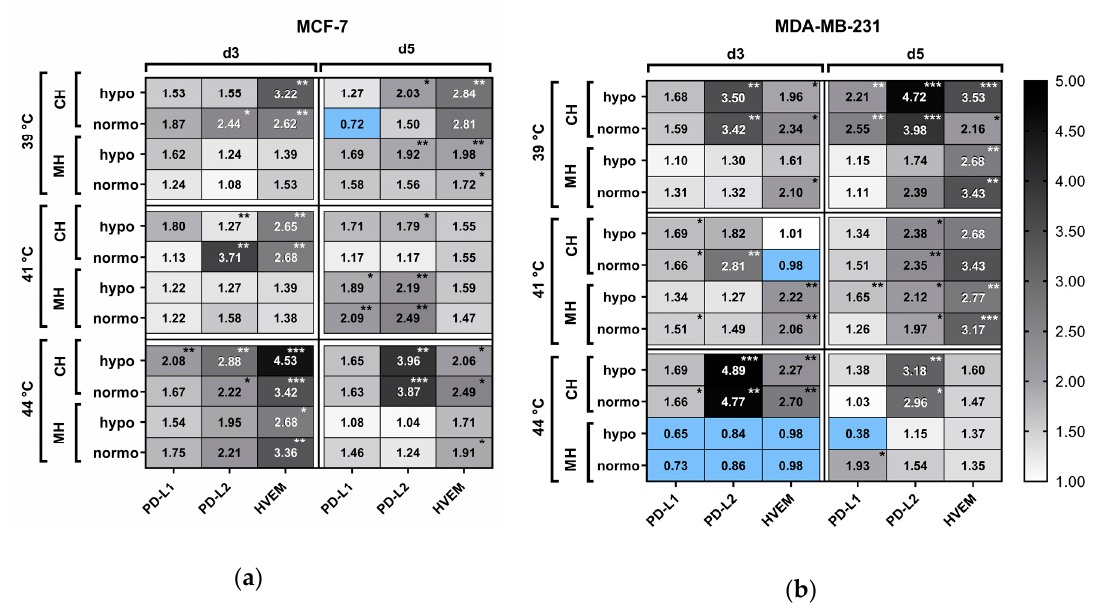
Figure 10. Heatmap of normalized expression (change in mean fluorescence intensity compared to mock-treated cells)) of immune suppressive immune checkpoint molecules on cell the cell surface of ( a ) MCF-7 and ( b ) MDA-MB-231 breast cancer cells after combinatory treatment of conventional warm-water (CH) or microwave heating (MH) and radiotherapy. Cells were heated either CH or MH within the self-designed hyperthermia system to three clinically relevant temperatures, i.e., 39 ◦ C, 41 ◦ C and 44 ◦ C, for an e ff ective time of 60 min. Afterwards, the cells were distributed into 75 cm 2 T-flasks for additional treatment, i.e., by normofractionated (normo) RT at single doses of 2 Gy or by hypofractionated (hypo) RT at single doses of 5 Gy, and analysis on d3 and d5.Significance test was conducted using Kruskal-Wallis test with uncorrected Dunn´s multiple comparison from three independent experiments, each measured in duplicates. * ( p < 0.1), ** ( p < 0.01), *** ( p < 0.001).